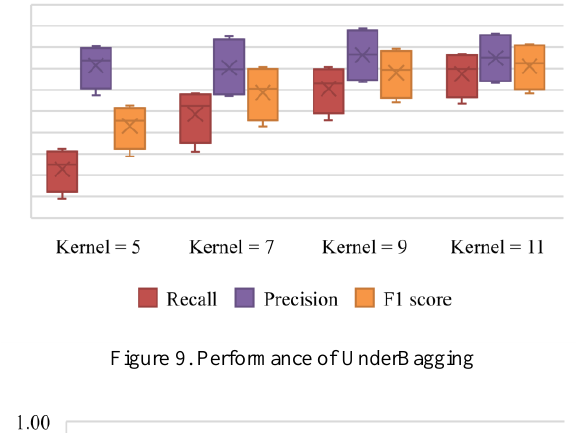
Figure 9. Performance of UnderBagging